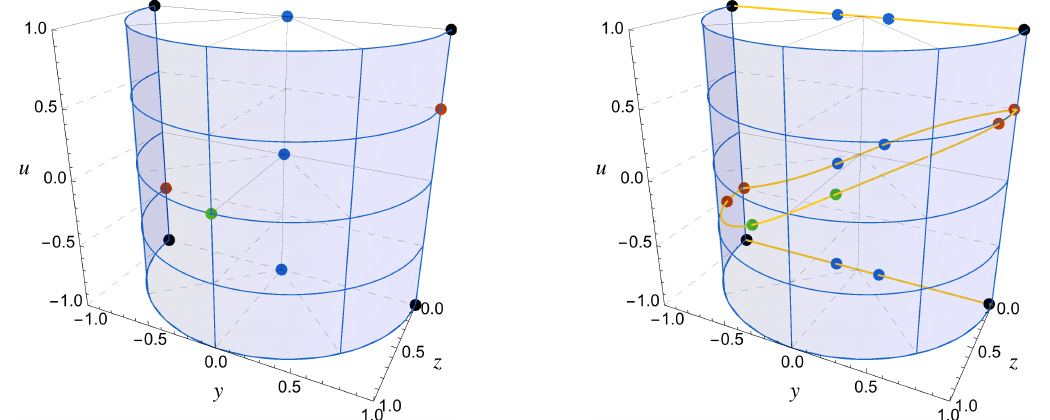
Figure 2. Left panel : the position of the fixed points ( u fp , y fp , z fp ) for a Gaussian potential and no interaction between dark matter (DM) and the 3-form. Right panel : the position of the fixed points changes when the interaction (9) is turned on with small coefficients α i . Depending on the value of the interaction coefficients, each of the fixed points can be decomposed in two new points which are shifted from the original position along the yellow